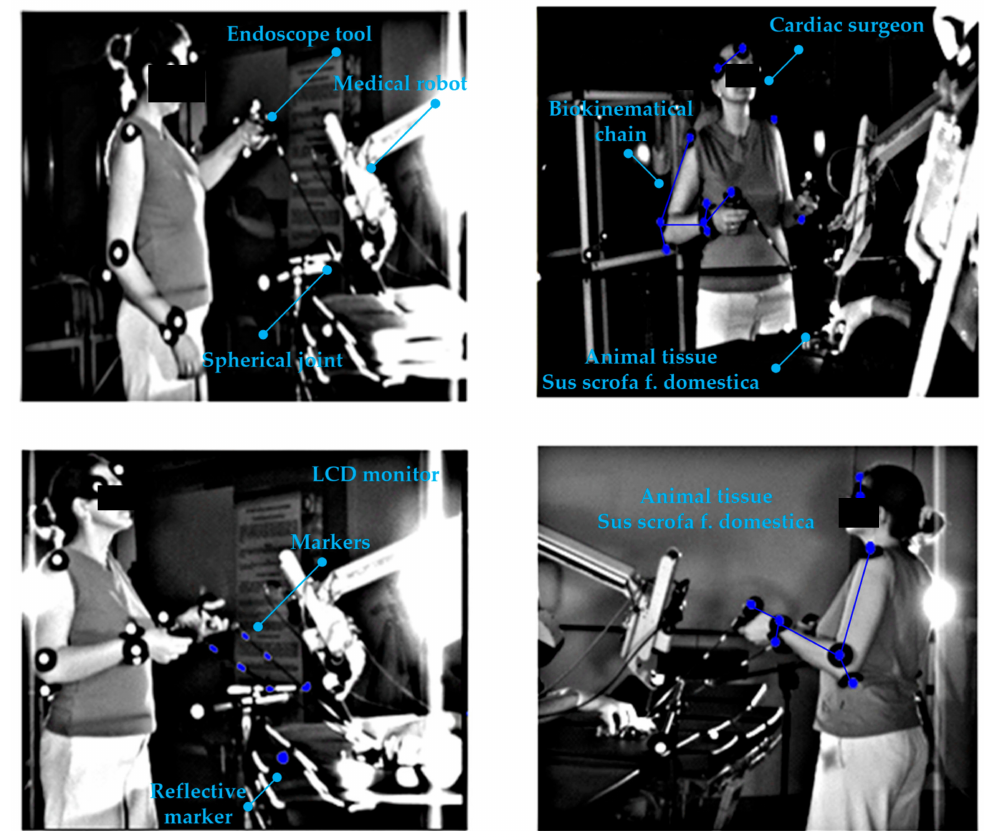
Figure 5. Endoscopic in vitro experiment on an animal preparation with the use of the surgical robot “Robin Heart Vision” and endoscopic instruments. Four optical CMOS sensors are used to acquire information about endoscopic tools displacements and the biokinematical chain of the cardiac surgeon.